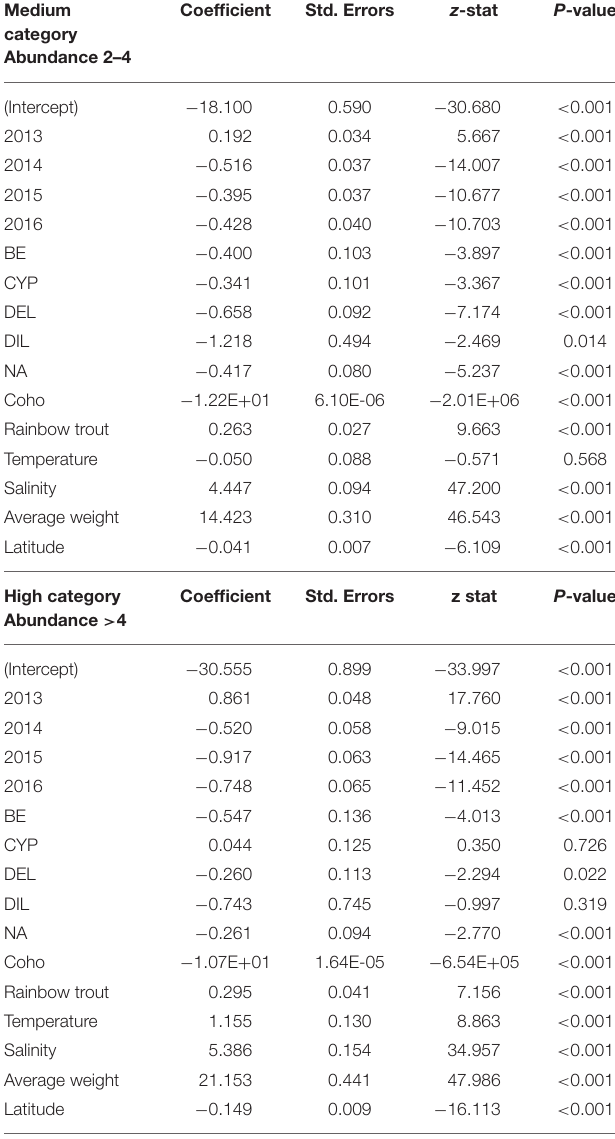
TABLE 2 | Results of the multinomial logistic model to quantify the association with production and environmental factors hypothesized to influence the C. rogercresseyi medium and high category in Chile during 2012–2016, compared to the baseline category as reference (year category: 2012, species: Atlantic salmon, and chemical ingredient: azamethiphos as reference